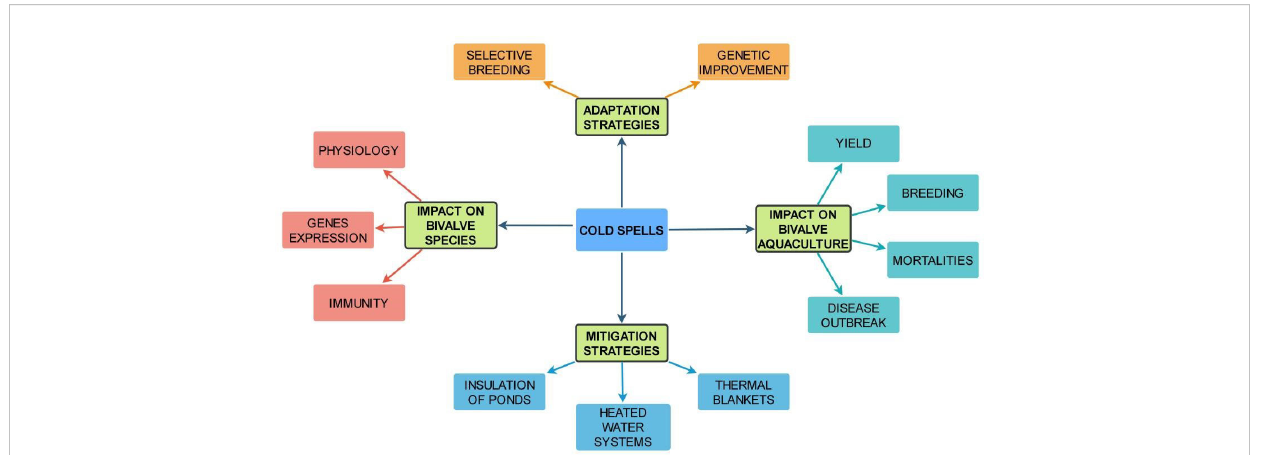
FIGURE 1 Effects of cold spells on bivalve species physiology, aquaculture yield, and adaptation/mitigation strategies. This fi gure summarizes the impact of cold spells on bivalve aquaculture, focusing on their effects on the physiology of bivalve species, and aquaculture yield, as well as the various adaptation and mitigation strategies employed to mitigate these